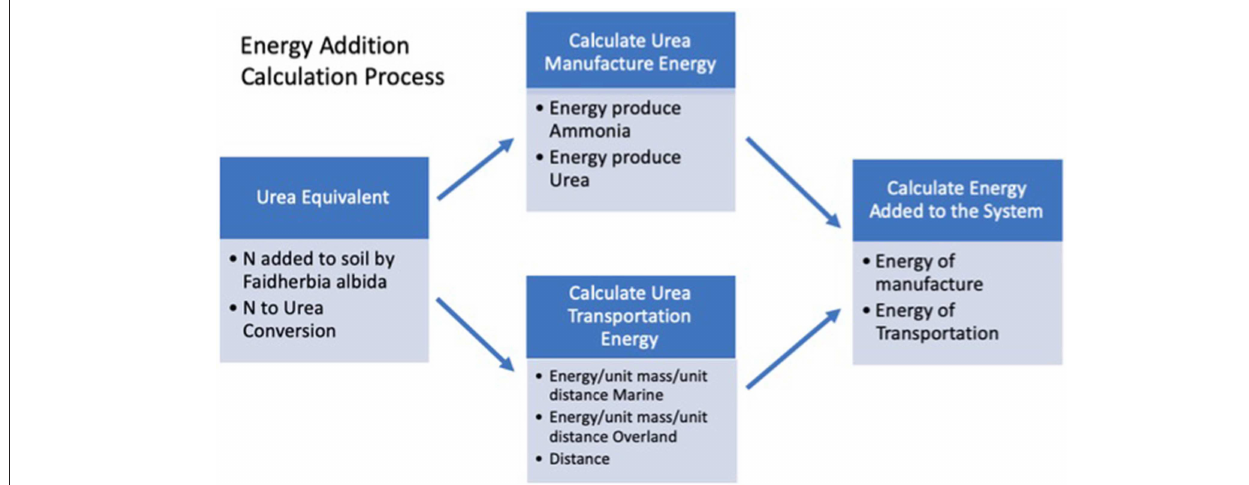
FIGURE 1 | Faidherbia albida energy addition calculation process.